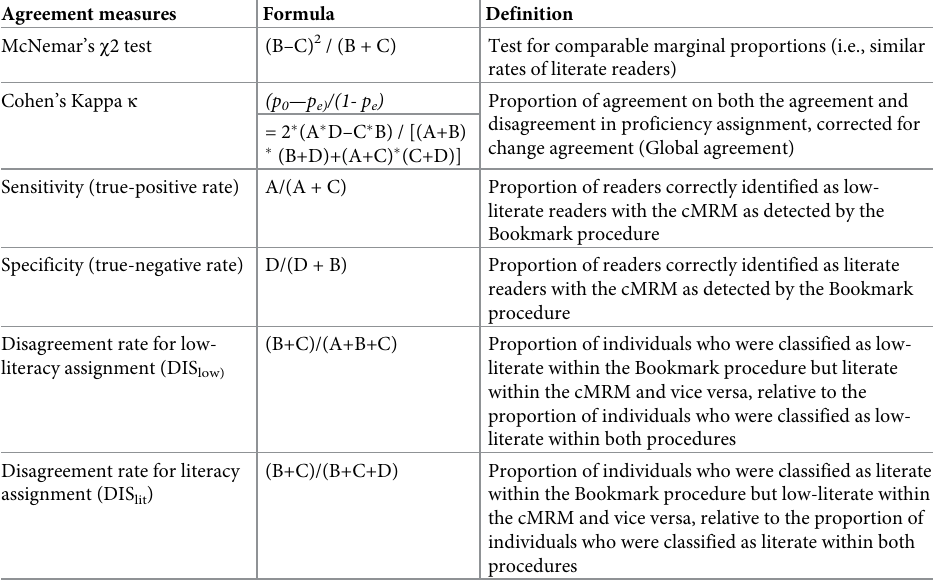
Table 2. Agreement